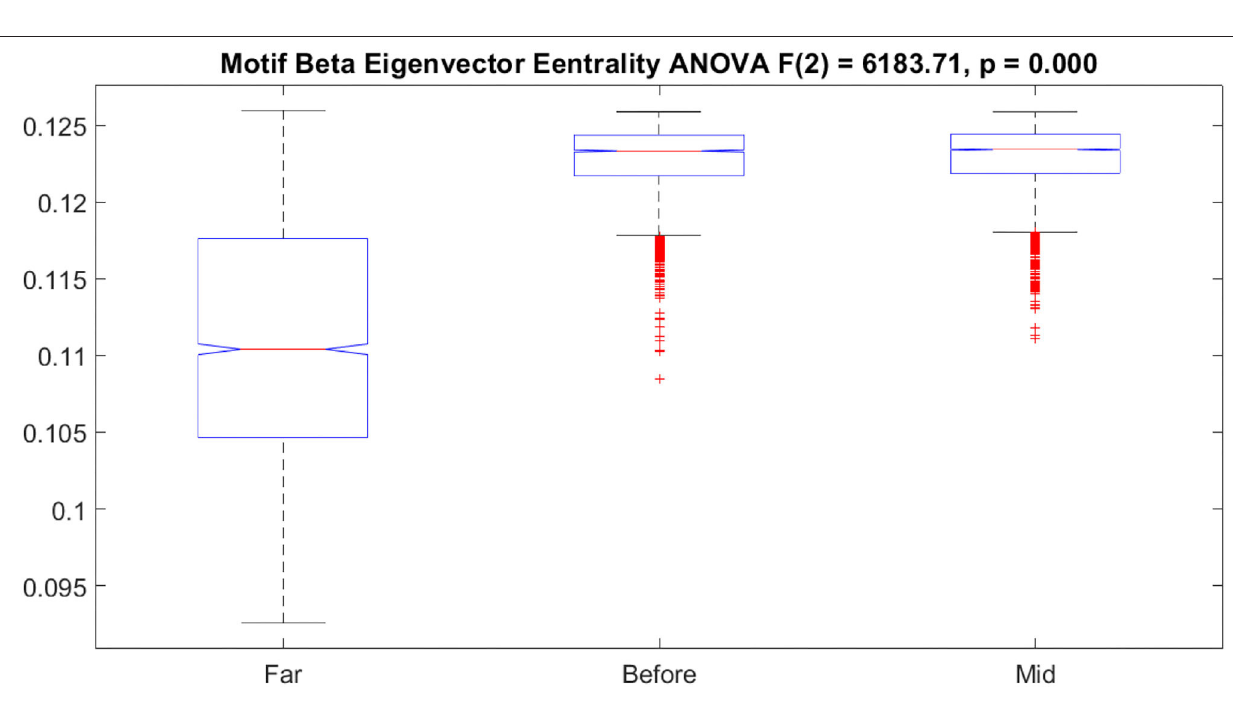
Frontiers in Neurology |